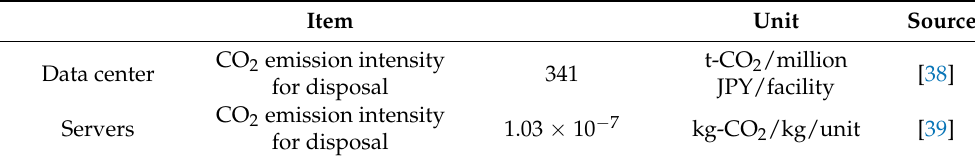
Table 4. Utilized data for dispose process.